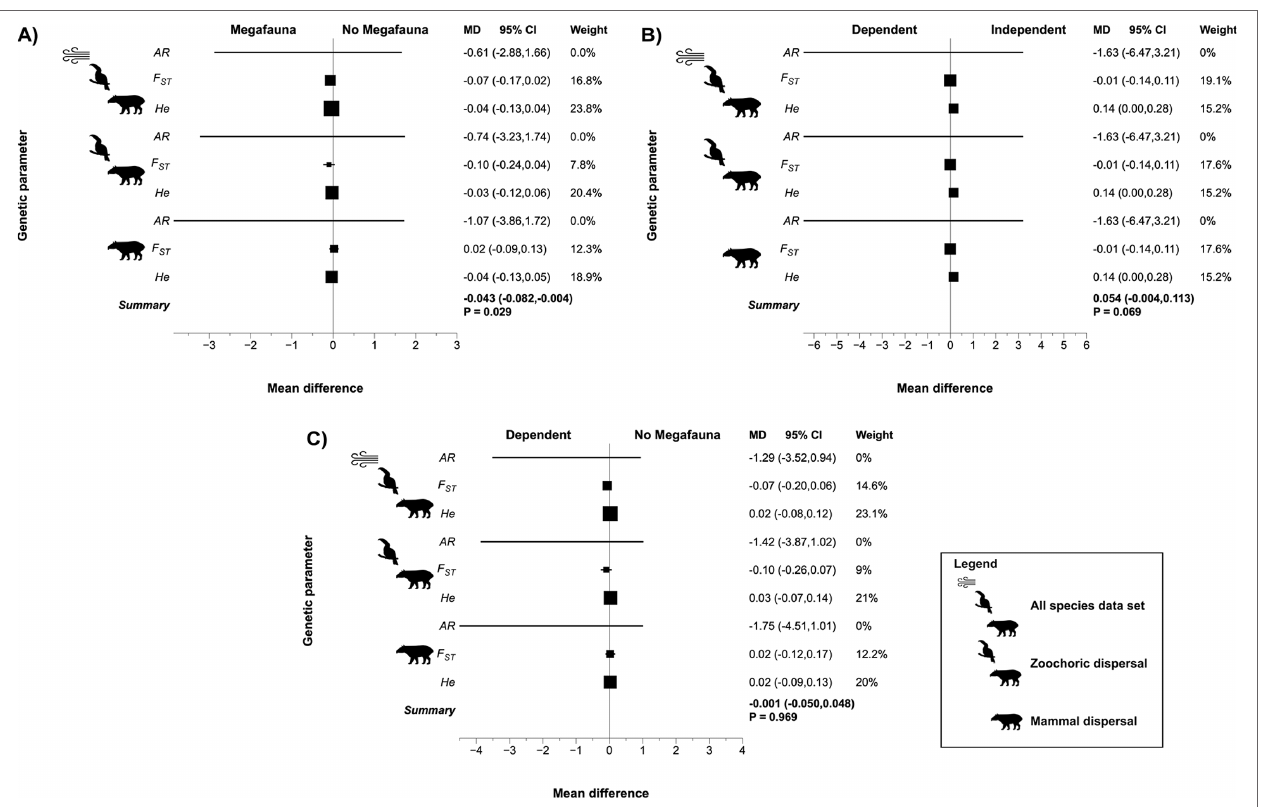
FIGURE 1 | Effect of megafauna seed dispersal syndromes on genetic parameters across the three data sets for plant species with megafauna and no megafauna syndromes based on phylogenetic-dependent meta-analysis. (A) Effect size for species with megafauna versus no megafauna syndrome dispersal. (B) Effect size for megafauna-dependent versus megafauna-independent species. (C) Effect size for megafauna-dependent versus no megafauna syndrome